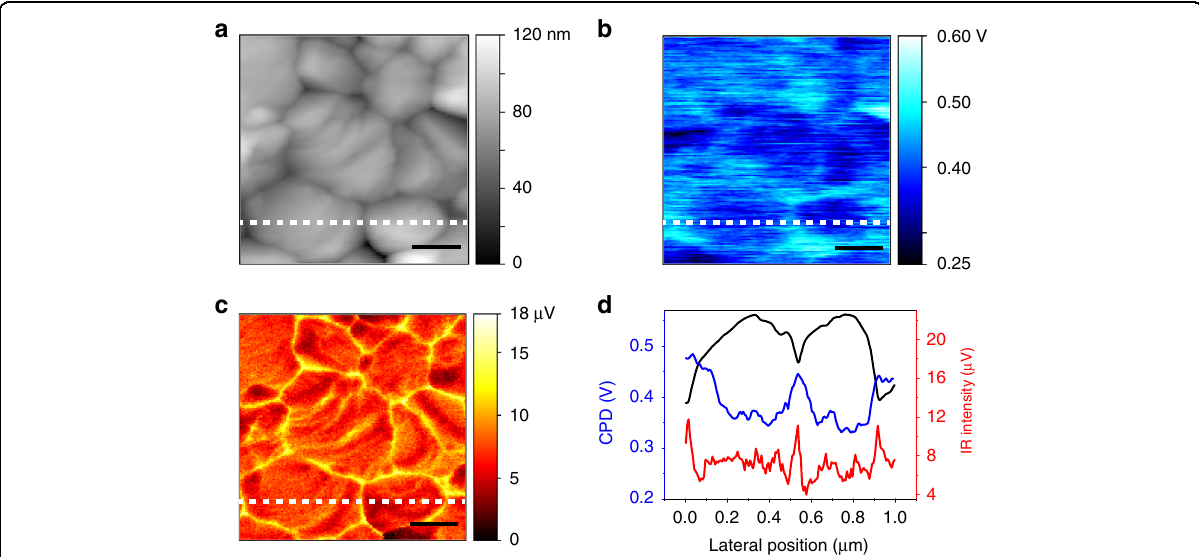
Fig. 4 Correlative KPFM and s-SNOM nanoimaging on perovskite. a AFM topography (1 μ m × 1 μ m); b Contact potential difference (CPD); and c simultaneously acquired infrared near- fi eld image; d one-dimensional line pro fi les of the topography, CPD and infrared near- fi eld amplitude along the white dashed lines marked in a – c . The scale bars are 200